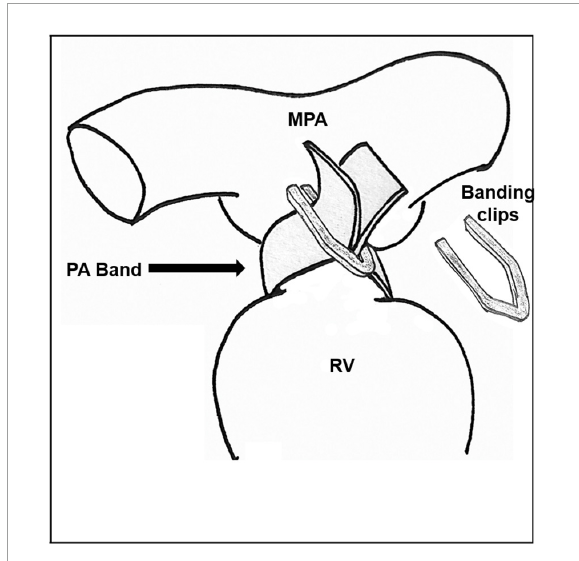
FIGURE1 Pulmonary artery banding technique. RV, right ventricle; MPA, Main pulmonary artery; PA, Pulmonary